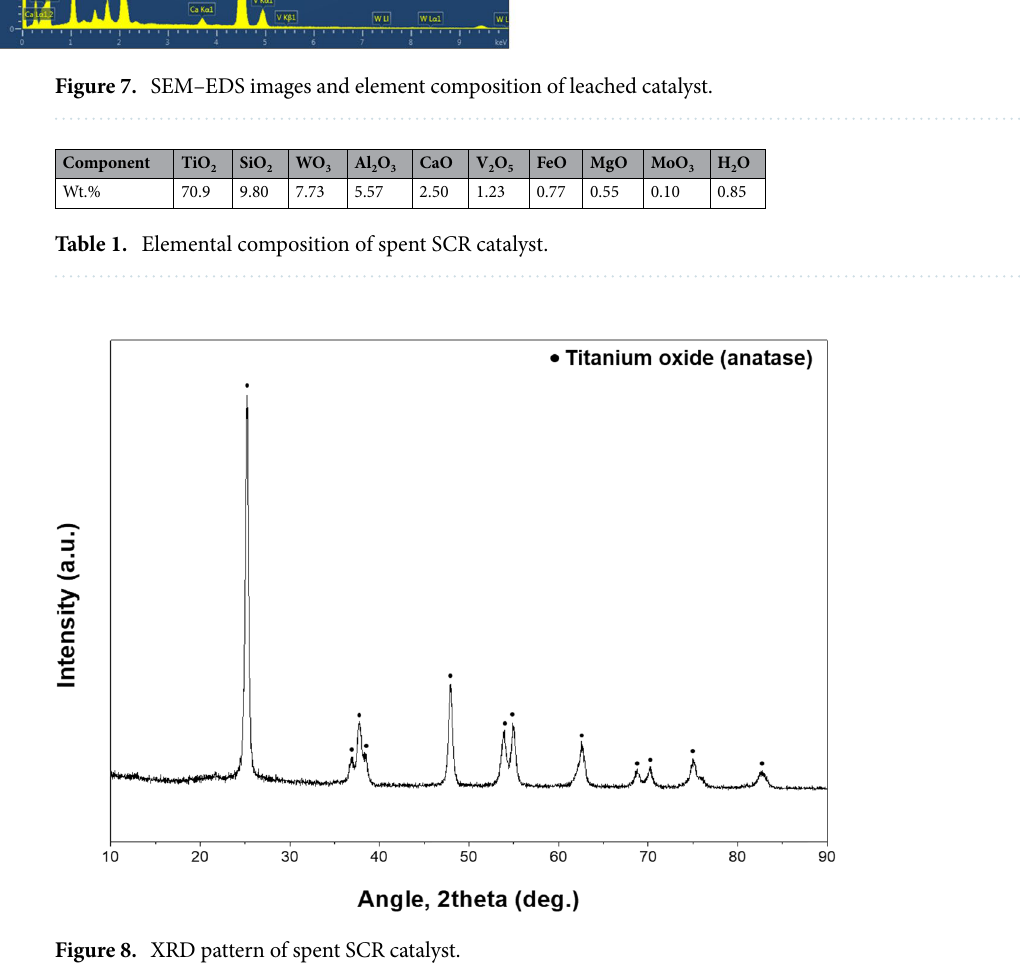
Figure 8. XRD pattern of spent SCR